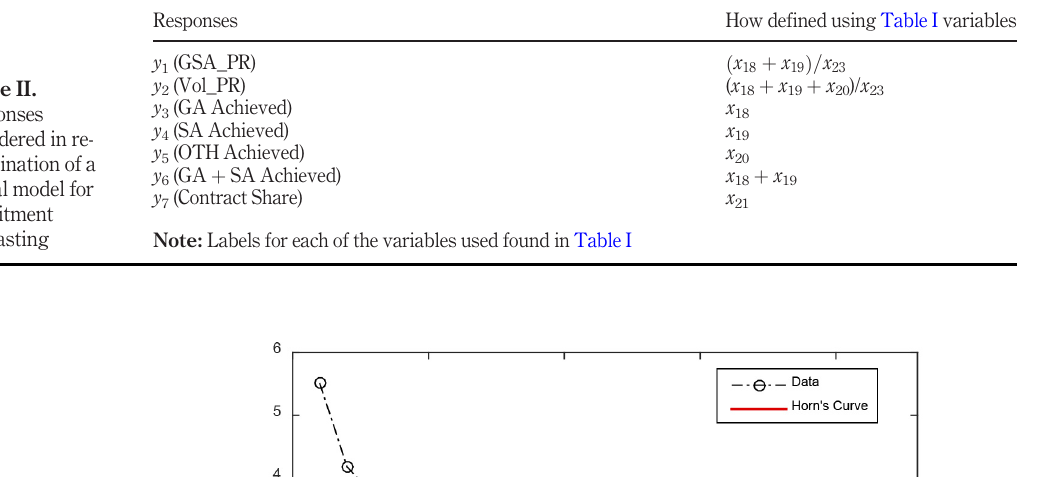
Figure 1. Principal component eigenvalues and Horn ’ s curve for independent variable